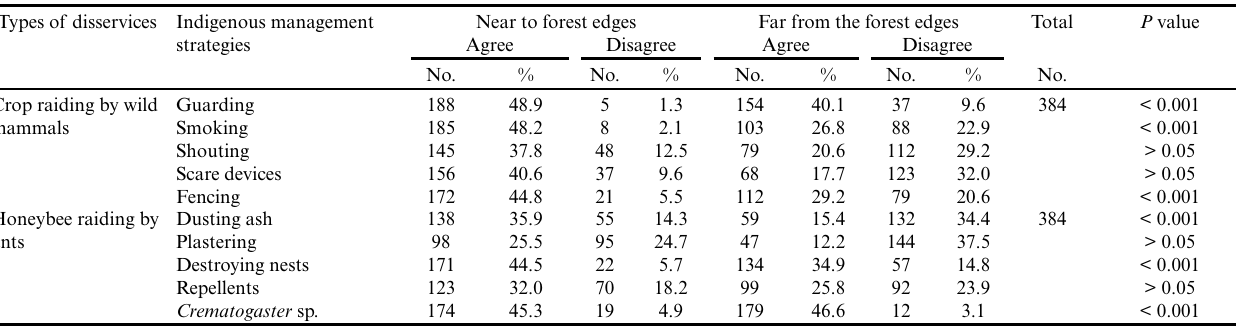
Table 7. Farmers’ responses regarding indigenous management strategies for ecosystem disservices at different proximities to forests. P values are from chi-square